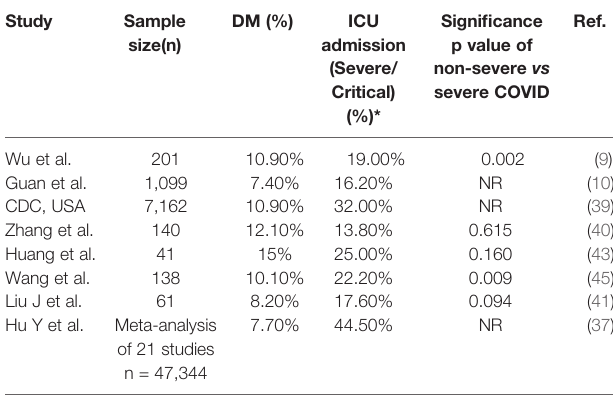
TABLE 2 | Prevalence of diabetes amongst non-severe and severe COVID-19 infected patients. Study Sample